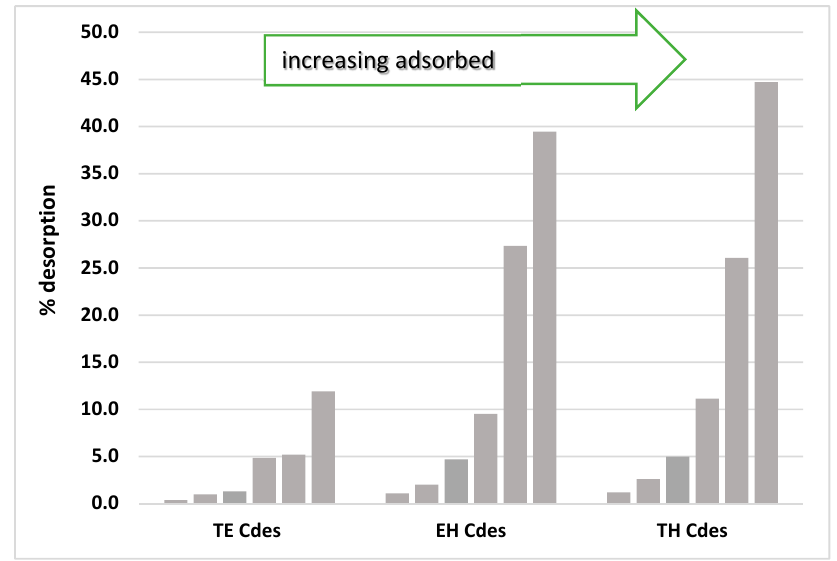
Figure 3. Desorption percentage in the three soils in relation to increasing adsorbed quantities.